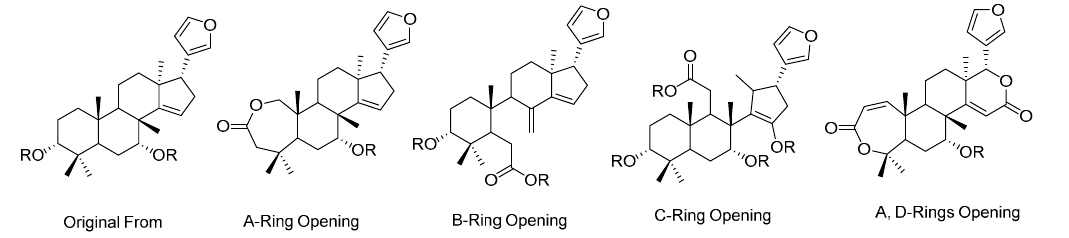
Figure 2. Several types of limonoid